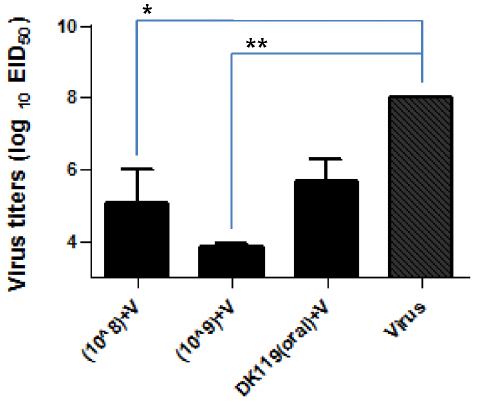
Figure 7. DK119 pretreatment promotes lung viral clearance after influenza virus infection. Lung viral titers at day 4 post infection with H1N1 influenza virus A/PR8 are determined and presented in log10 units of limiting dilutions showing viral replication in chicken eggs. (10ˆ8) + V: mice intranasally pretreated with DK119 (10 8 CFU) and infected with A/PR8 virus in the presence of DK119 (10 8 ). (10ˆ9) + V: mice intranasally pretreated with DK119 (10 7 CFU) and infected with A/PR8 virus in the presence of DK119 (10 9 ). DK119 (oral) + V: mice orally pretreated with DK119 (10 9 CFU) for 10 days and then infected with A/PR8 virus. Virus: Naı¨ve mice infected with A/PR8 virus (2.5 LD 50 ). * (p , 0.05), ** (p , 0.001) statistical significances are indicated. Bars indicate standard errors.